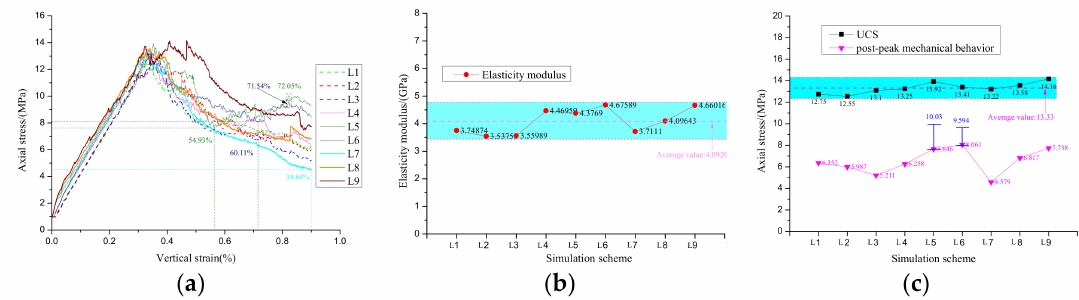
Figure 15. Mechanical characteristics of mineral circles at different positions: ( a ) stress–strain curve, ( b ) elastic modulus, ( c ) axial